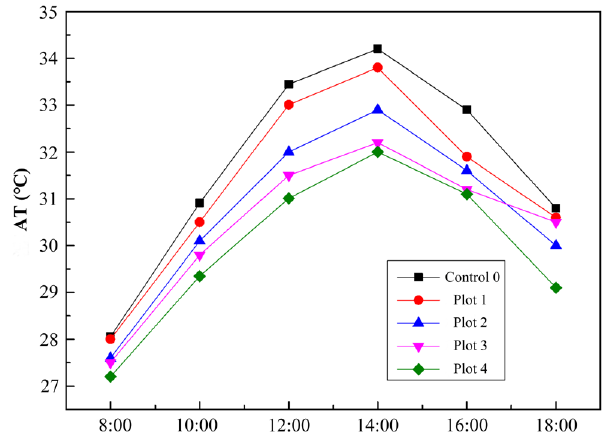
Figure 2. The air temperature changes at different plots.